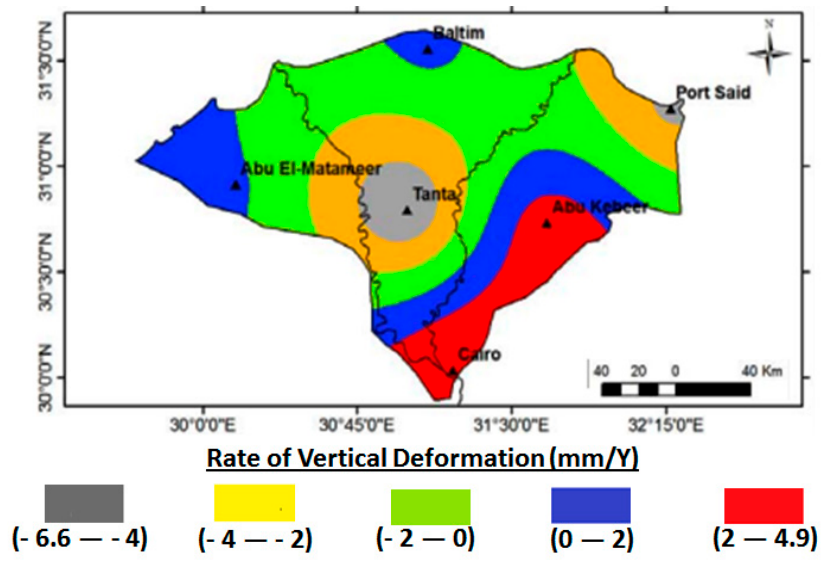
Figure 2. Land subsidence rate using repeated GPS observations for six stations over the Nile Delta (Modified after Hoda et al. [30]).